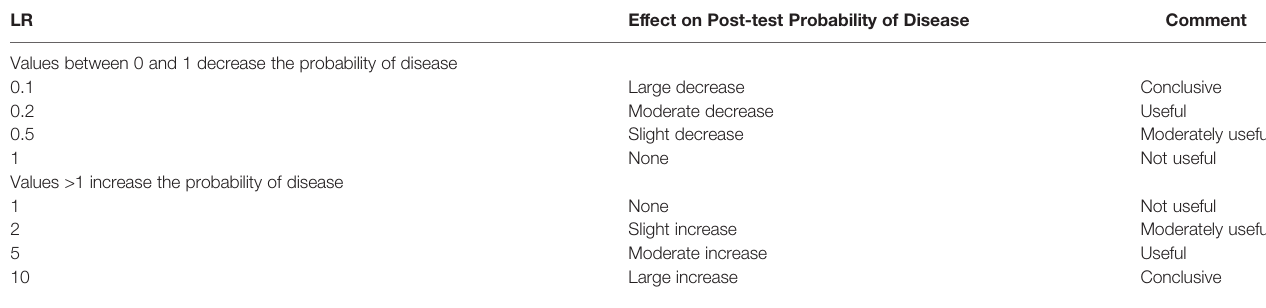
TABLE 1 | Interpretation of the LR. LR Values between 0 and 1 decrease the probability of disease